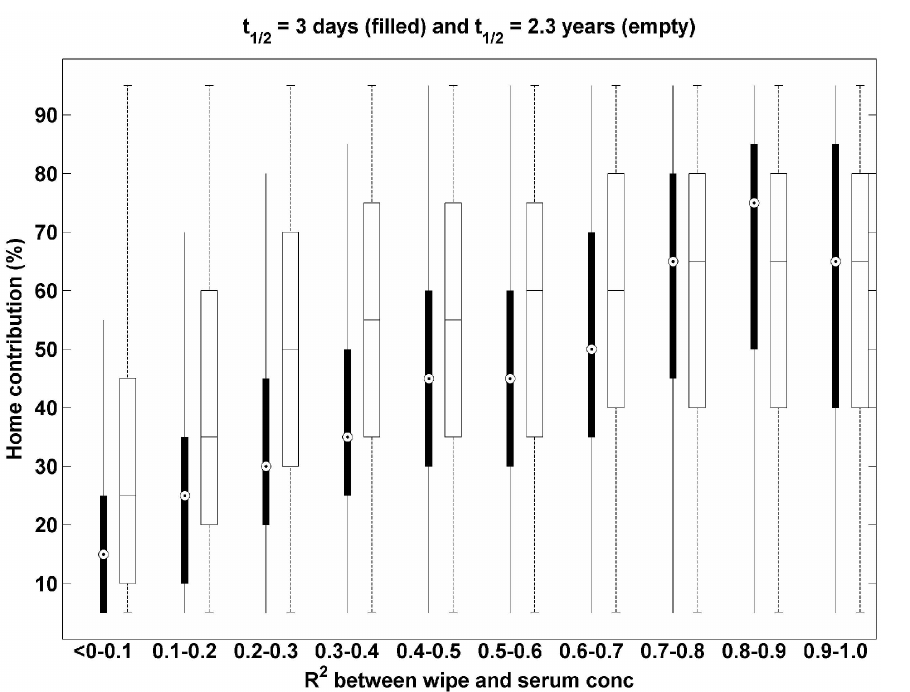
Figure 2. Contribution of home exposure (%) to total exposure with different R 2 for two compounds with 3 days of half-life (filled) and 2.3 years of half-life (empty).